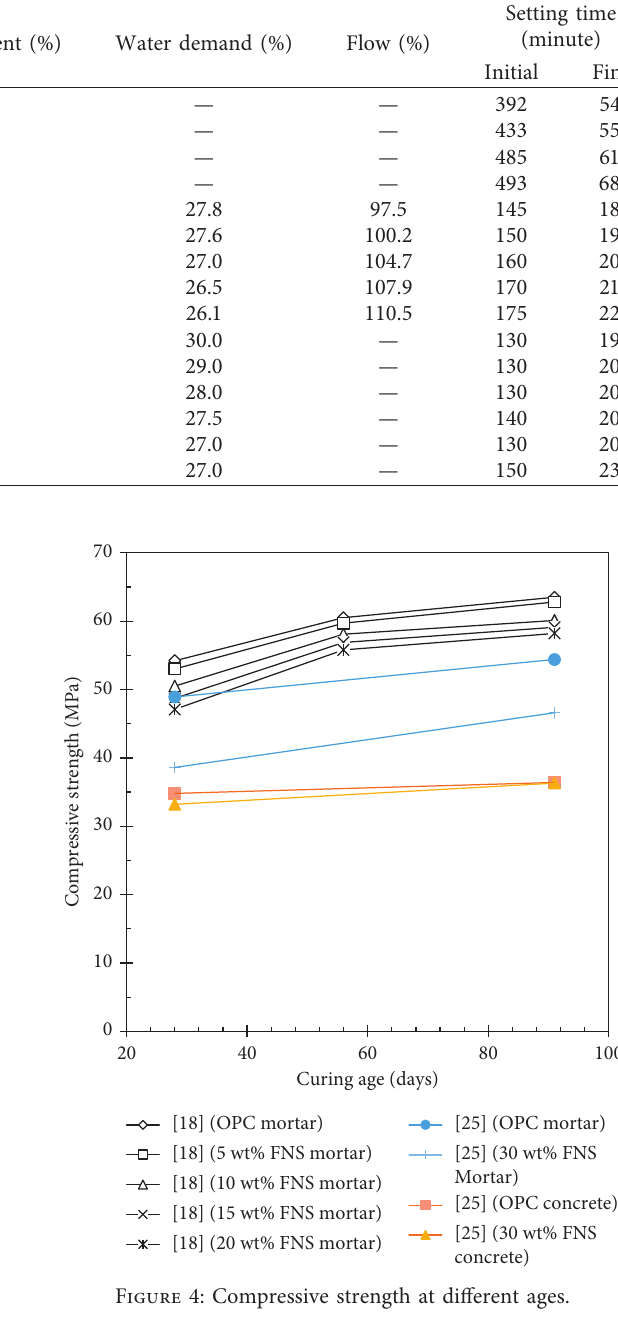
Table 2: Summary of properties of FNS cement at the fresh state.